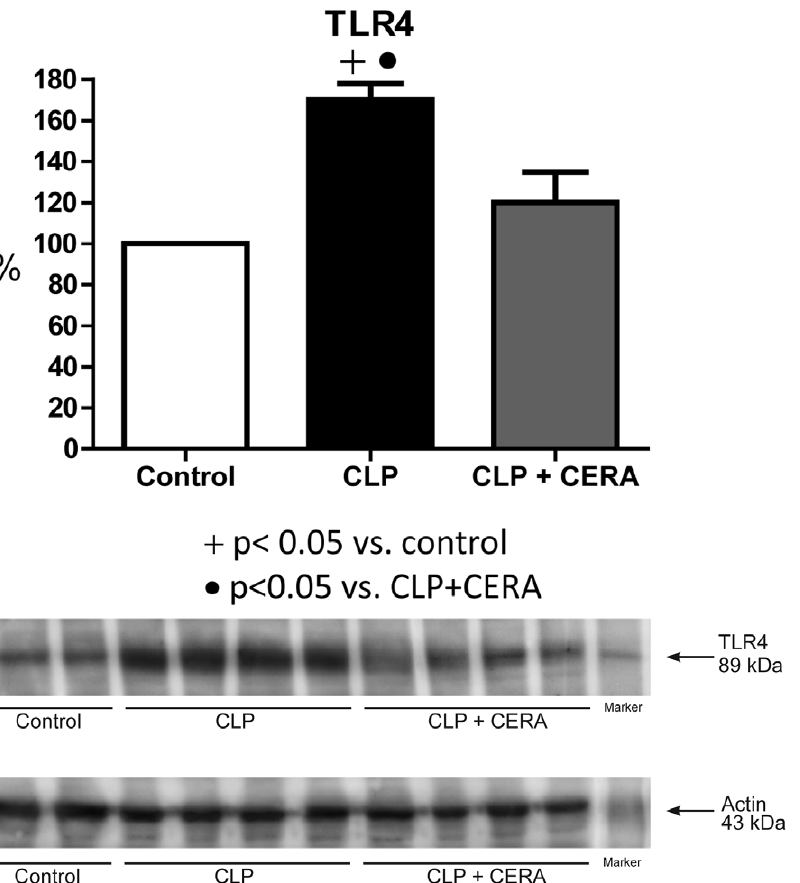
Figure 4. Immunoblots reacted with anti-Toll-like receptor 4 antibody (1:100), revealing an 89-kDa band. Semiquantitative immunoblots prepared from kidney samples. Densitometric analysis of samples from control rats, rats submitted to cecal ligation and puncture only, and rats treated with continuous erythropoietin receptor activator prior to undergoing cecal ligation and puncture. Differences among the means were compared by analysis of variance followed by the Student-Newman-Keuls test. p . 0.05 for control vs. CLP + CERA. CLP, cecal ligation and puncture; CERA, continuous erythropoietin receptor activator; TLR4, Toll-like receptor 4.